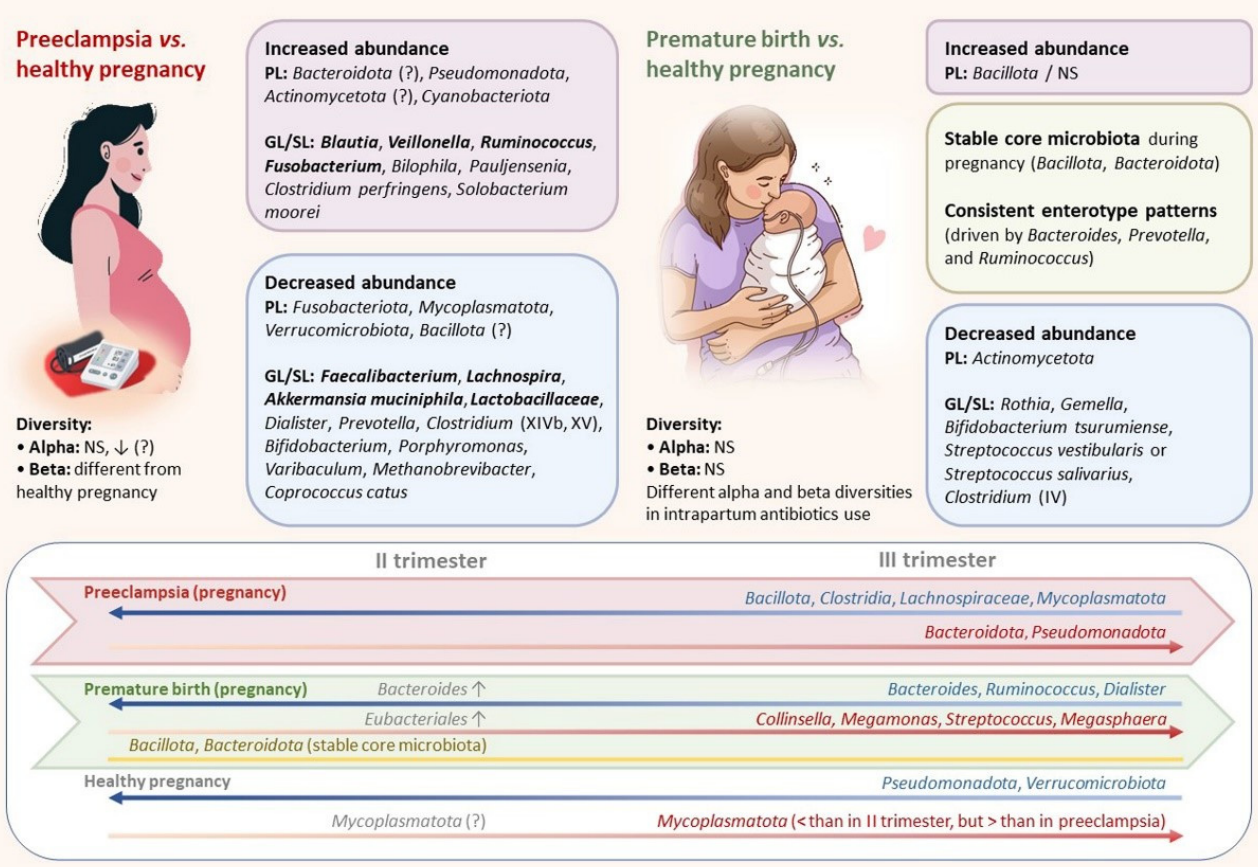
Figure 1. Features of maternal intestinal microbiome in preeclampsia and in premature birth. Abbreviations: PL—phylum level; GL/SL—genus level/species level; NS—not significant; (?)—research data are controversial. Taxa associated with clinical characteristics (according to research data) are in bold. This figure has been designed using assets from Freepik.com (accessed on 24 December 2022).